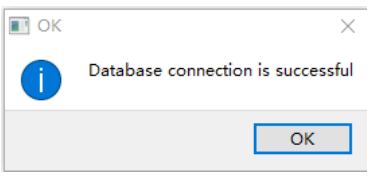
Fig. 7 Successful database connection.